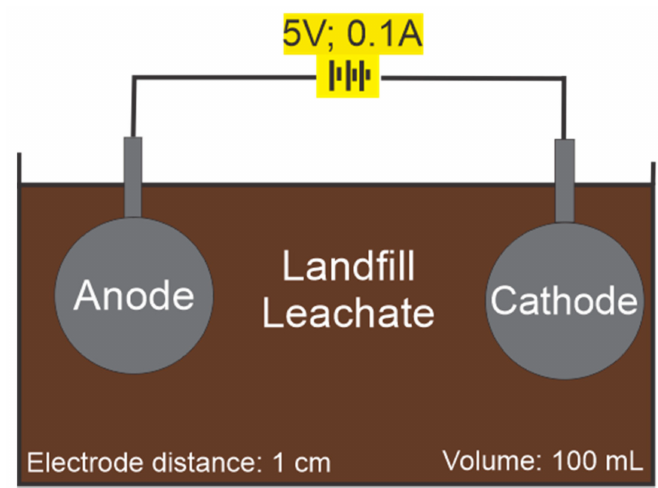
Figure 2. Schematic of the experimental electrocoagulation